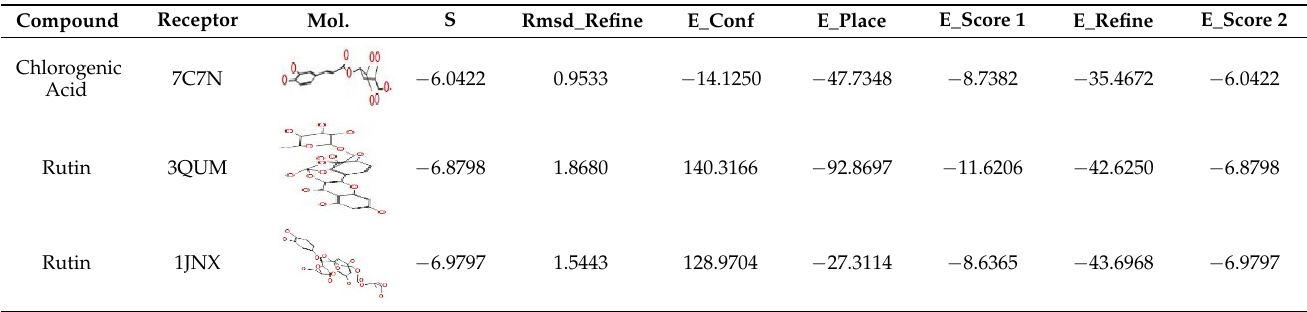
Table 5. The best possible conformations of compounds inside the protein central activity.